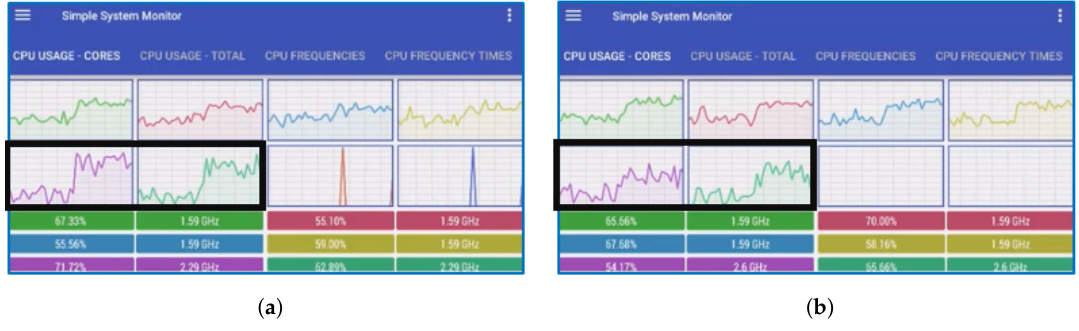
Figure 16. Comparison of the big cores use rates between the conventional and proposed tile partitioning methods.